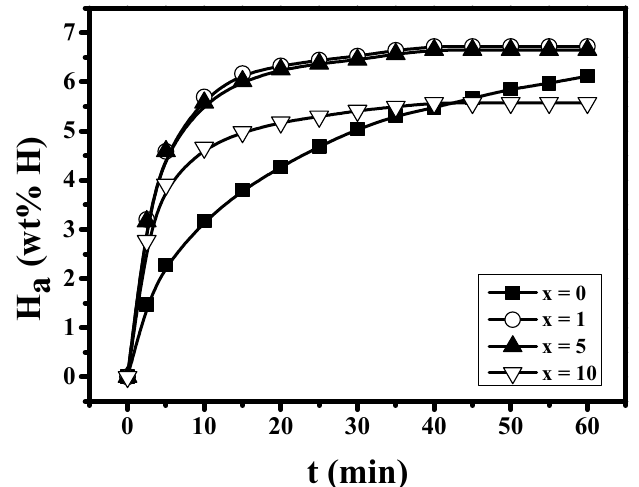
Figure 4. H a versus t curves at 593 K under 12 bar H 2 at n = 1 for Mg-xMgH 2 -1.25Ni-1.25TaF 5 -1.25VCl 3 (x = 0, 1, 5, and 10).